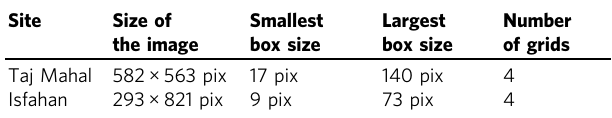
Table 1 Parameters for the box-counting